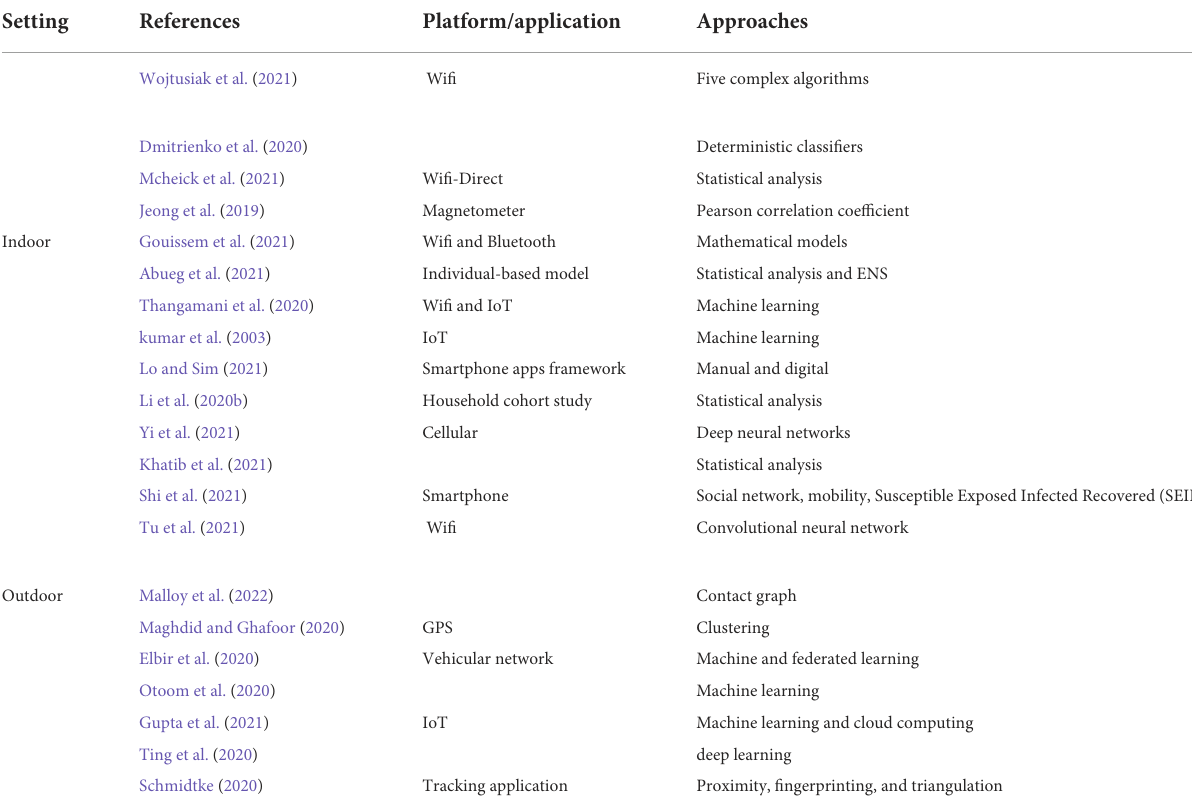
TABLE 4 Summary of the papers on contact tracing reviewed in this survey.